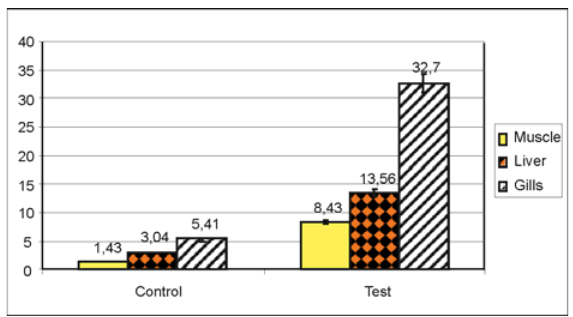
Fig. 15. Zinc concentration (mg/kg) in tissues of rainbow trout In both cases the MPC indicated in the Lithuanian hygiene standard (40 mg Zn/kg) was not